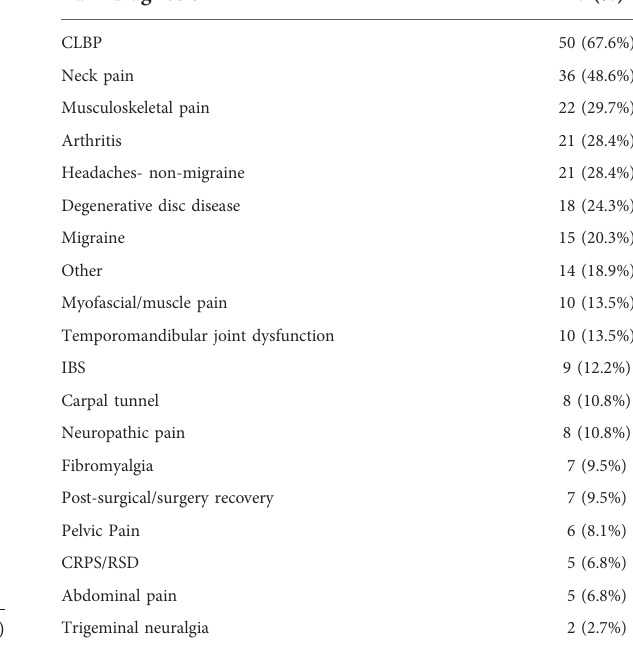
TABLE 2 Pain diagnoses of the trial sample ( N